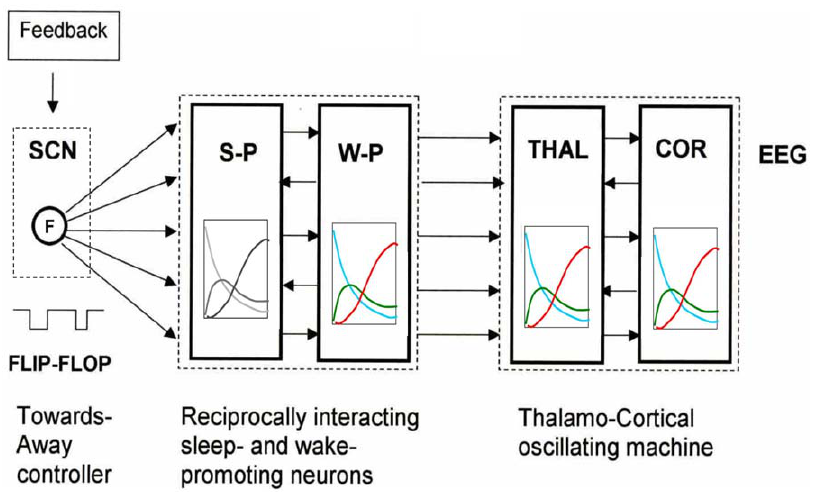
Figure 6. SCN to EEG: a graphic summary of the NTP model for NREM sleep structure. Dual control by the SCN switch and the NTP model equations: the SCN, the acknowledged time-keeper of the brain, changes its level of activity under the influence of feedback from several sources in particular homeostatic drive, it then uses these changes to create a flip-flop (F) timing control that switches downstream action between the two dynamic states going towards and going away from deep sleep i.e. between P 1 P 2 and P 3 P 4 . These instructions are conveyed to the sleep-promoting (S-P) and wake-promoting (W-P) population pair which by reciprocal interaction are locked in anti-phase, like the 2 ends of a see-saw. Here the NTP equations take over and determine, as generating population at the brainstem, the template pattern of firing-rate time-courses of the brainstem activating neurons. The template propagates downstream and modulates thalamic output. Thalamocortical networks then form the complex wave sequences observed on the EEG, while following the power time-course pattern dictated by the brainstem. For simplicity, only the first towards phase of the template pattern is shown in the inset boxes. The box for the S-P population is in grayscale to indicate that the vertical axis is different from that of the colored patterns following: it indicates the fraction of neurons in each equivalent firing-rate mode ( b , s and d ) corresponding to the cascade (relatively silent R moderate firing-rate R fast firing-rate) rather than the cascade (fast firing-rate R moderate firing-rate R relatively silent) in the colored patterns. Thus the mean firing-rate in the S-P population (grayscale) progressively increases with time, while in the W-P population (colour) it decreases.